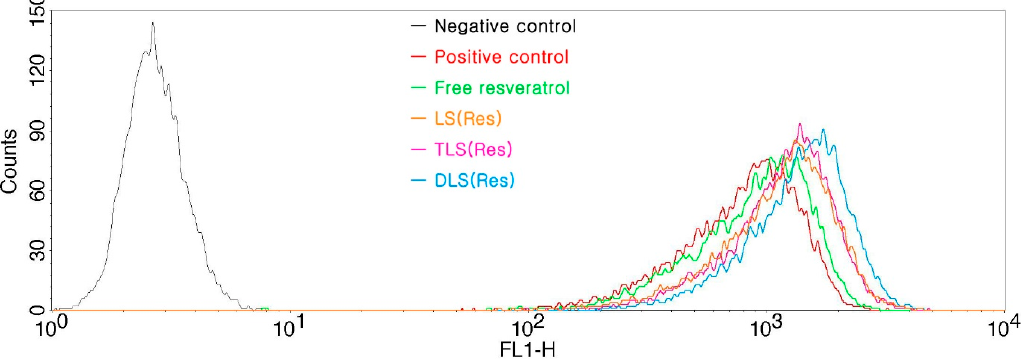
Figure 9. Reactive oxygen species (ROS) production measured with DCFH-DA in B16F10 cells treated with free resveratrol, LS (Res), TLS (Res) and DLS (Res) after 12 h of incubation. Production of ROS was measured in fluorescence at excitation and emission wavelengths of 485 and 528 nm, respectively.